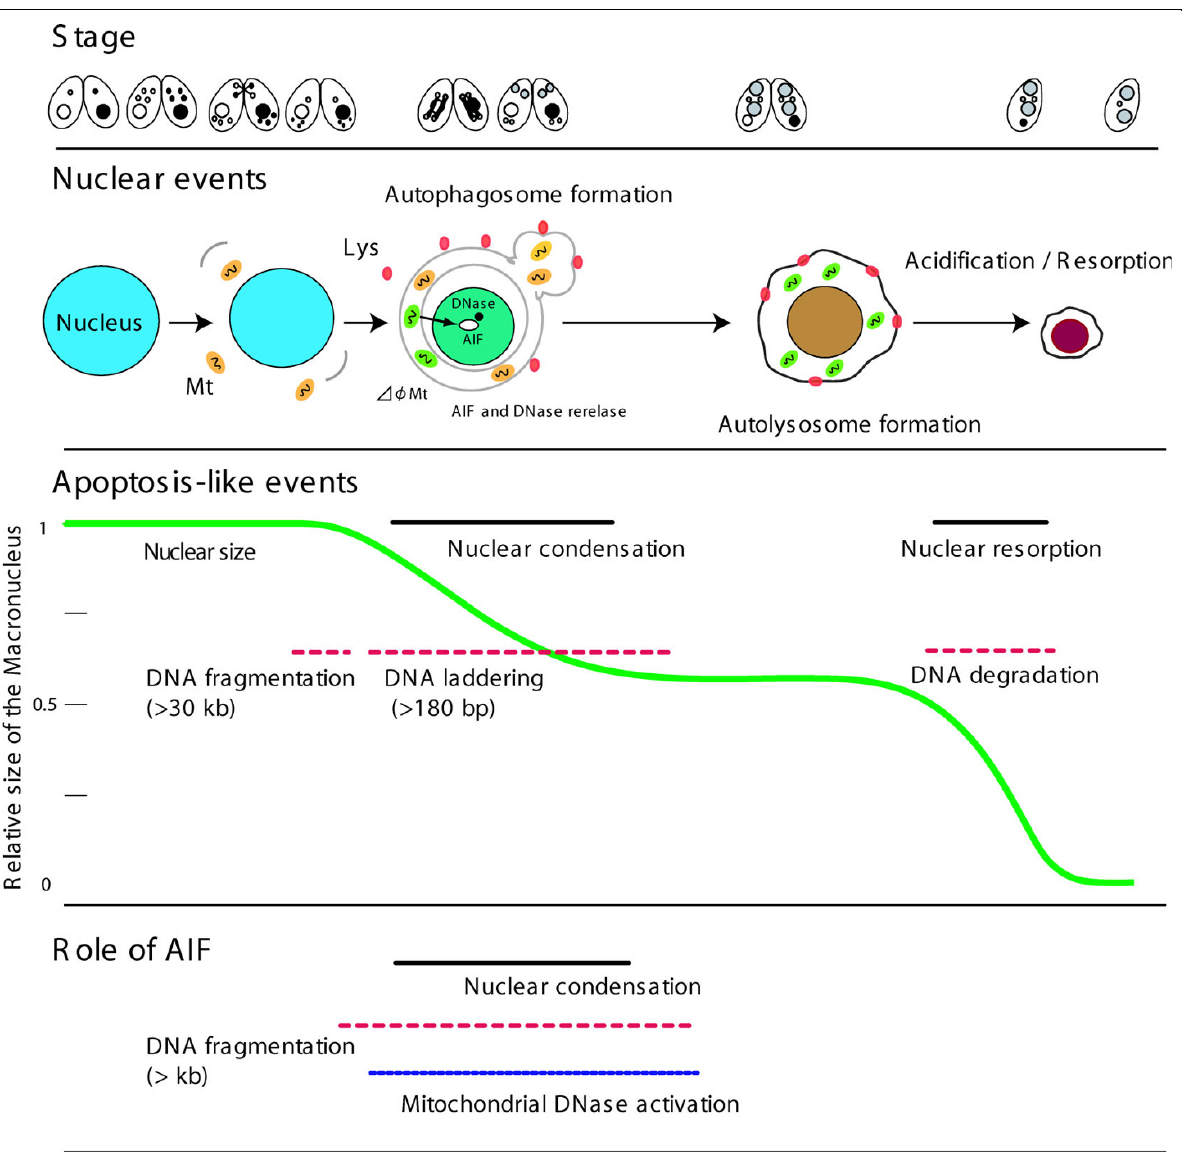
Figure 7 Schematic representation of PND and a possible role of AIF, based on information described in [6] and from the present study